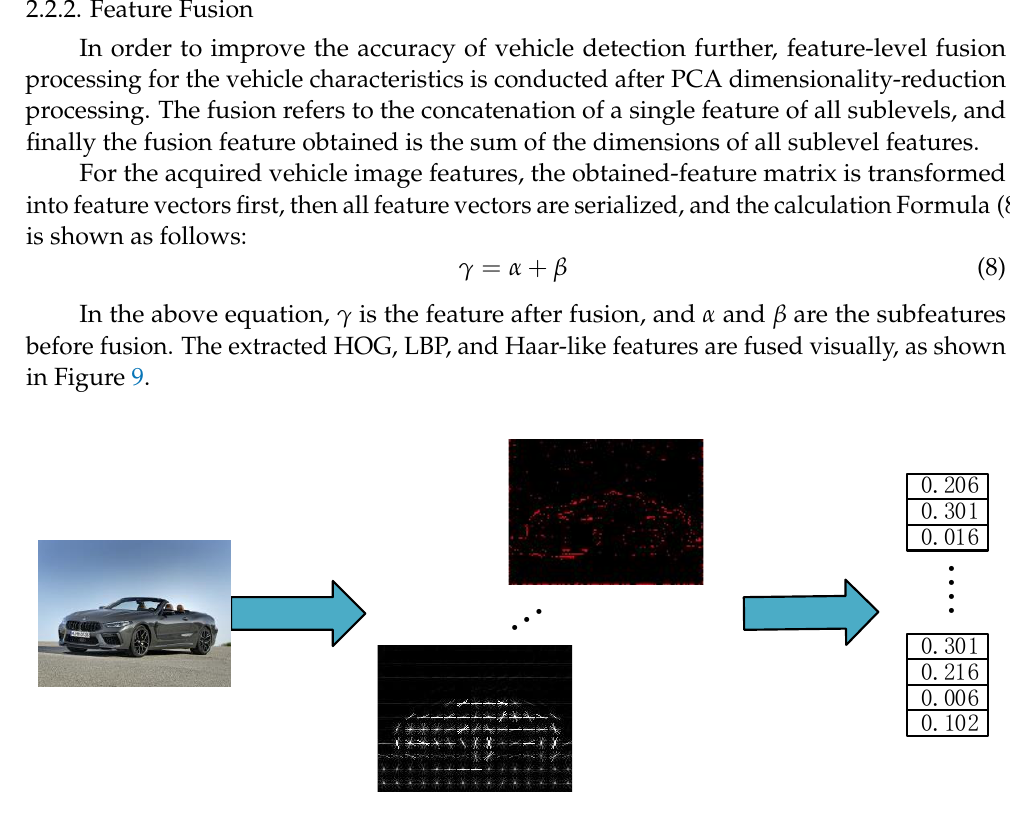
Figure 9. Feature-fusion process.